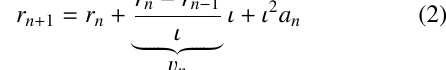
Figure 2. Delaunay-triangulation of a square grid with random connections due to spurious rounding errors from floating-point positions in (a) and rectified Delaunay-mesh in (b) obtained by deforming the mesh as shown in (c).